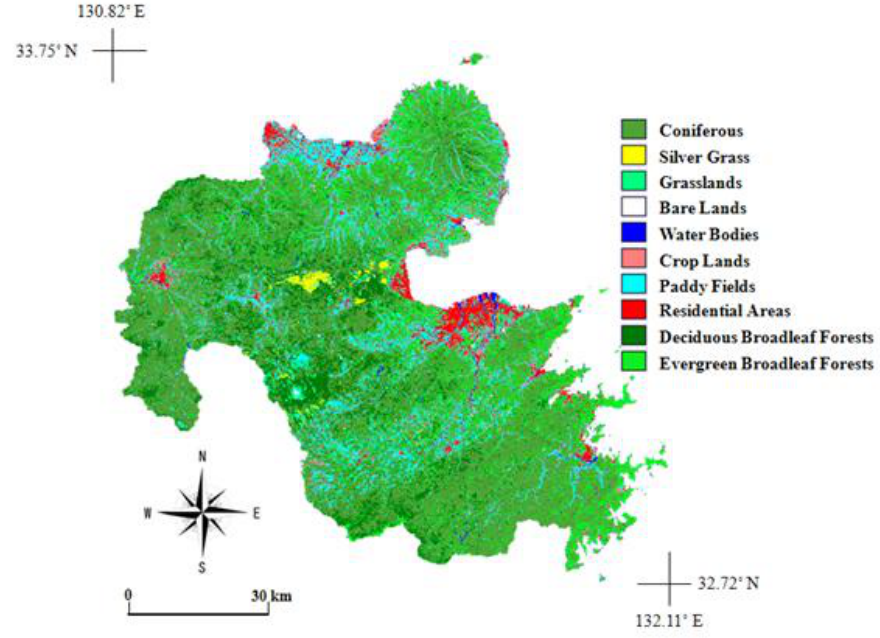
Figure 7. Classified LU/LC types in Oita Prefecture obtained by using the maximum likelihood